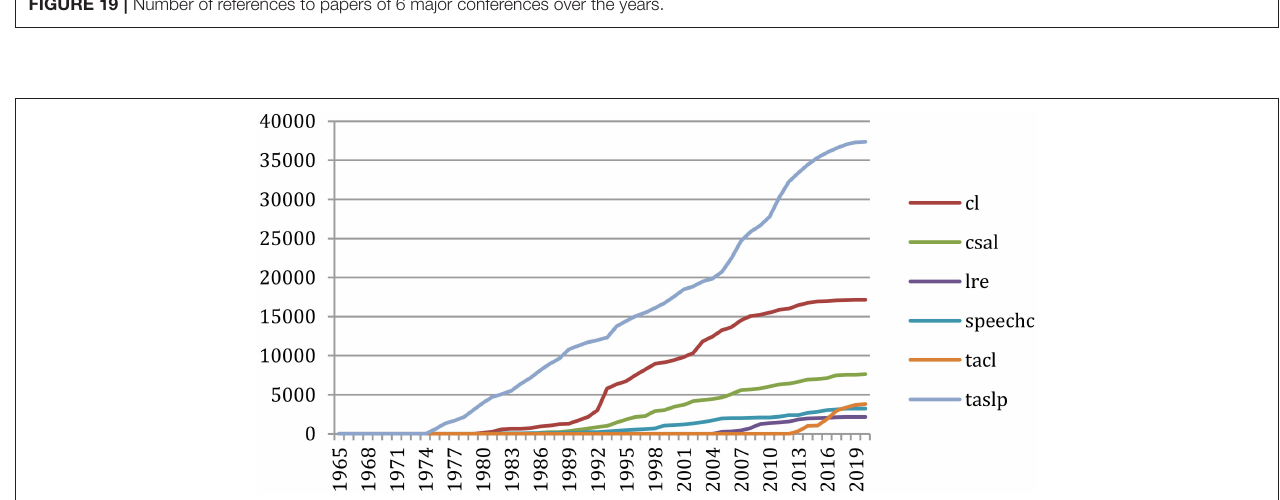
FIGURE 19 | Number of references to papers of 6 major conferences over the years.